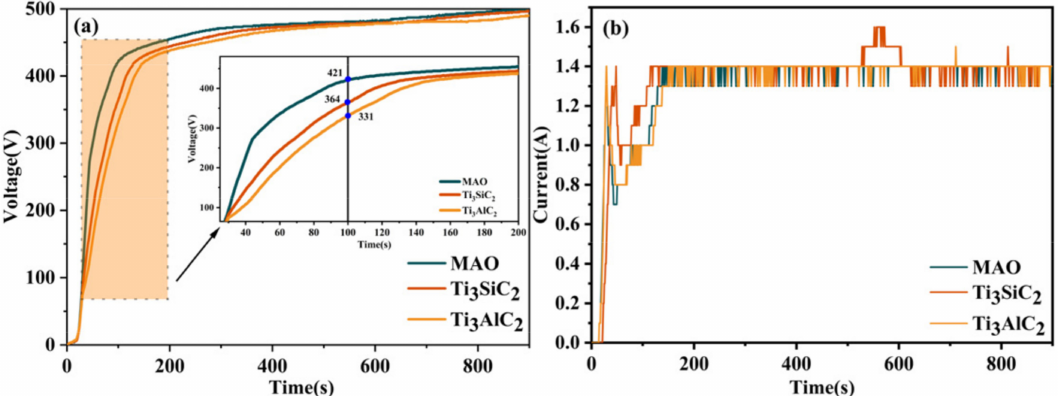
Figure 5. Results of ( a ) dynamic friction coefficient and ( b ) average friction coefficient and wear volume loss of MAO layer onTC4 alloy with different particle additions.